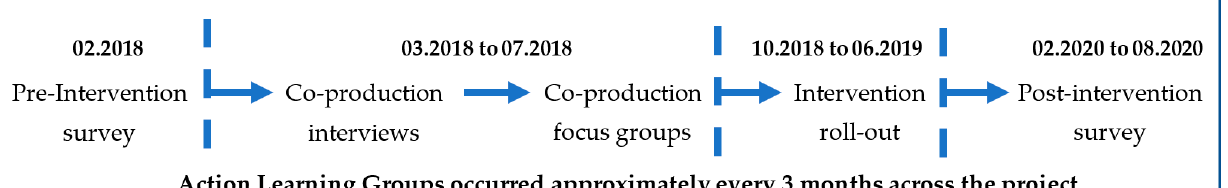
Figure 1. Project methods, timeline, and post-intervention survey.